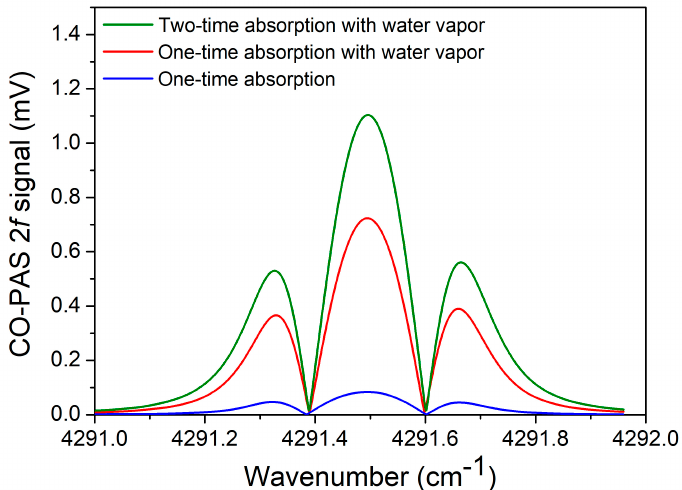
Figure 7. 2 f signal for CO-PAS detection with a modulation depth of 0.3 cm − 1 consisting of a one-time absorption, two-times absorption, and water vapor, respectively.